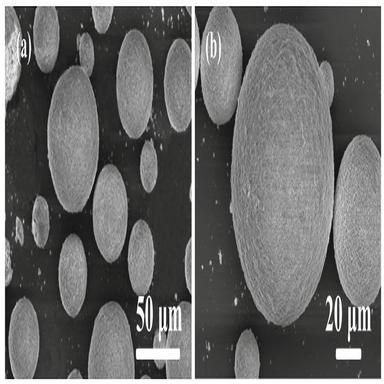
SEM images of the agglomerated powders (Lu2O3 + SiO2) after spray granulation: (a) overall morphology and (b) localized magnification morphology.